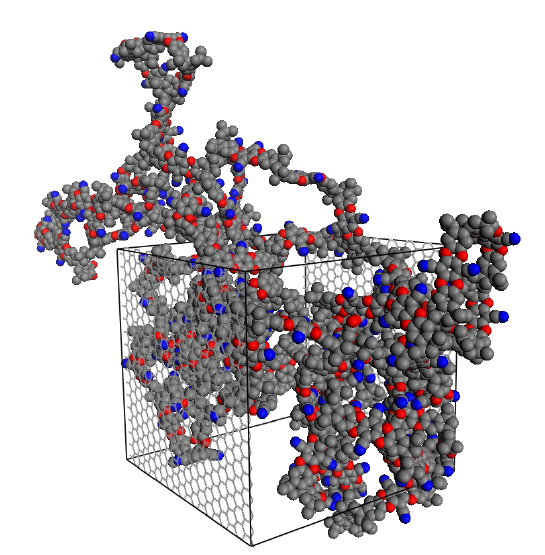
Figure 1. The final polymerized structure of the thin-slice PIM-1 (polymer of intrinsic microporosity) simulation box, PIM-1 (2D). The polymer is polymerized and periodic in the x and y dimensions, with the z dimension being capped by fluid-transparent rigid walls. The polymer is illustrated in unwrapped coordinates; however, periodic boundary conditions were used, with the wrapped coordinates sample shown in Figure 2.